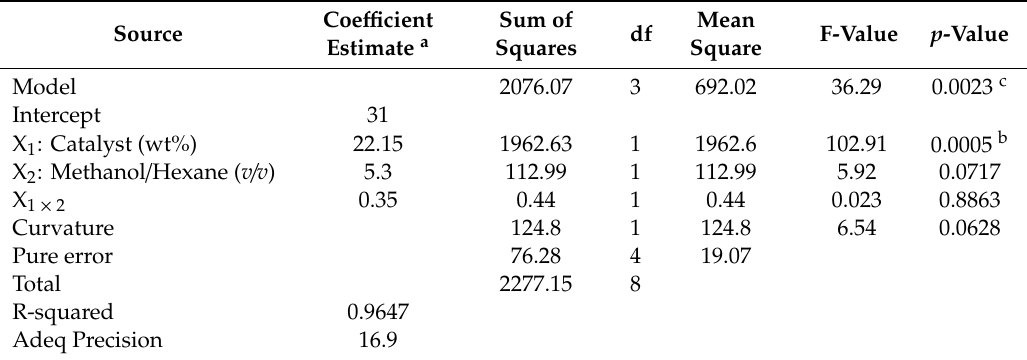
Table 3. ANOVA of the microalgae biomass transesterification